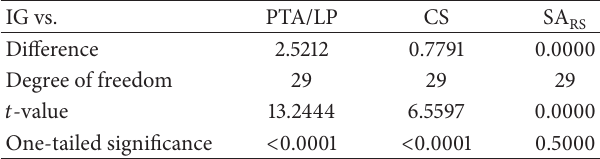
Table 8: Paired 𝑡 -tests on the average RER for I3 problem set.